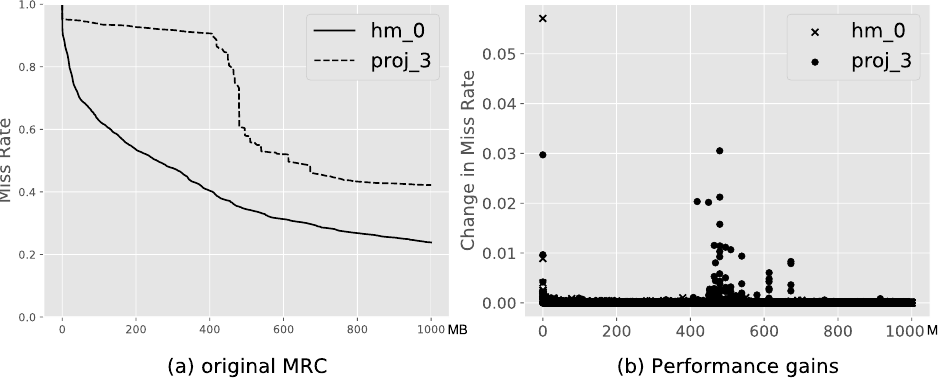
Figure 4. Cache Performance Gains as Capacity